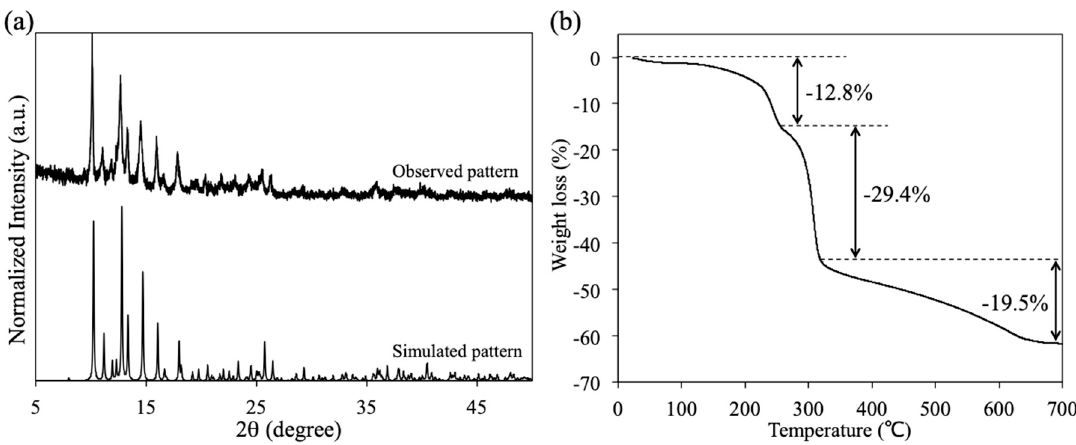
Figure 5. ( a ) Observed and simulated X-ray di ff raction (XRD) patterns of 1P and ( b ) thermo-gravimetric (TG) curve of 1P .